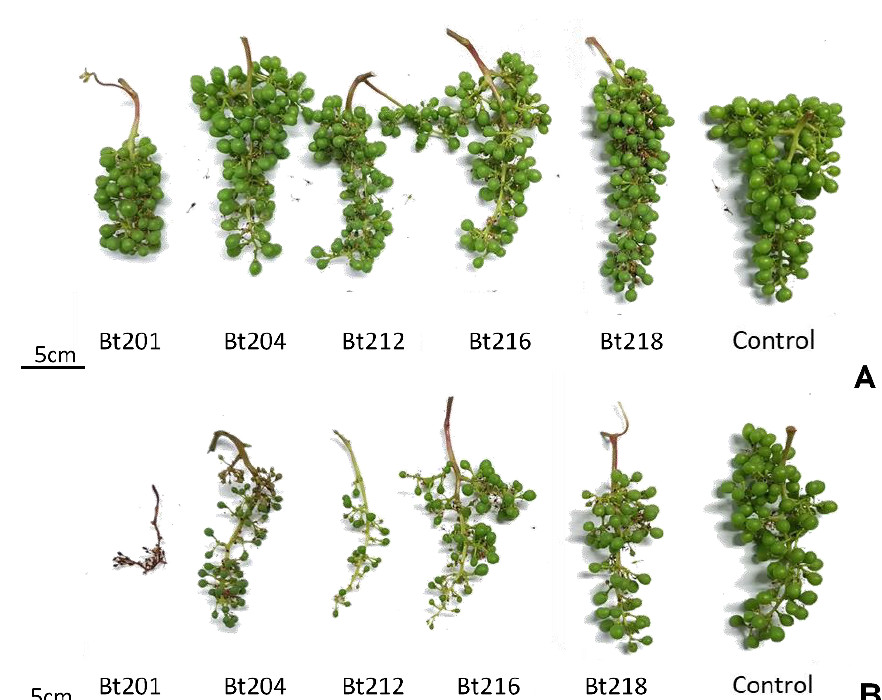
Figure 4. ( A ) best cluster from each inoculation/isolate; ( B ) worst cluster from each inoculation/isolate.